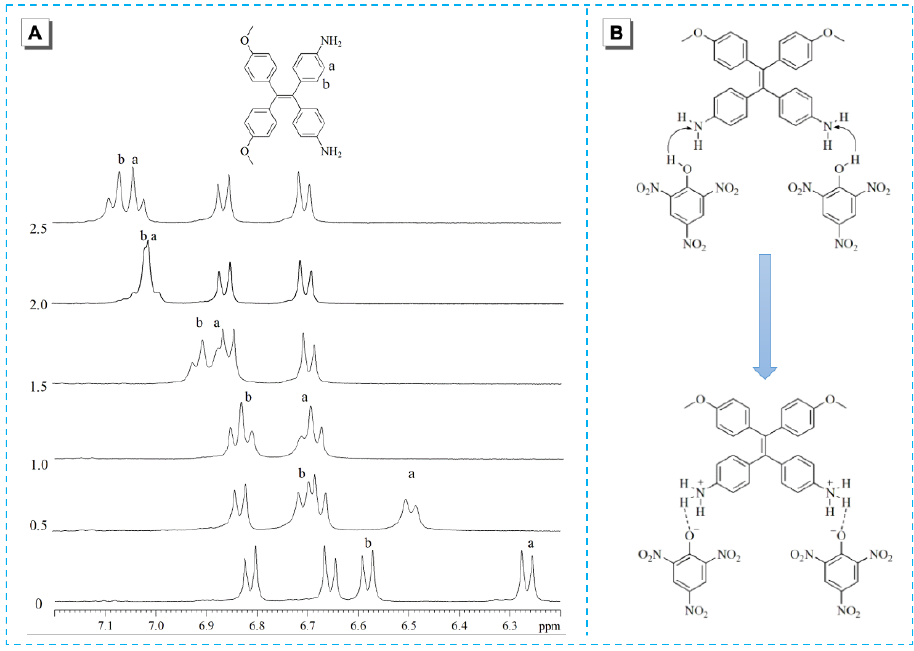
Figure 4. ( A ) Changes of 1 H NMR spectra of compound 3 (5 mM) in d 6 -DMSO with the addition of TNP. ( B ) The possible binding mode of compound 3 with TNP.